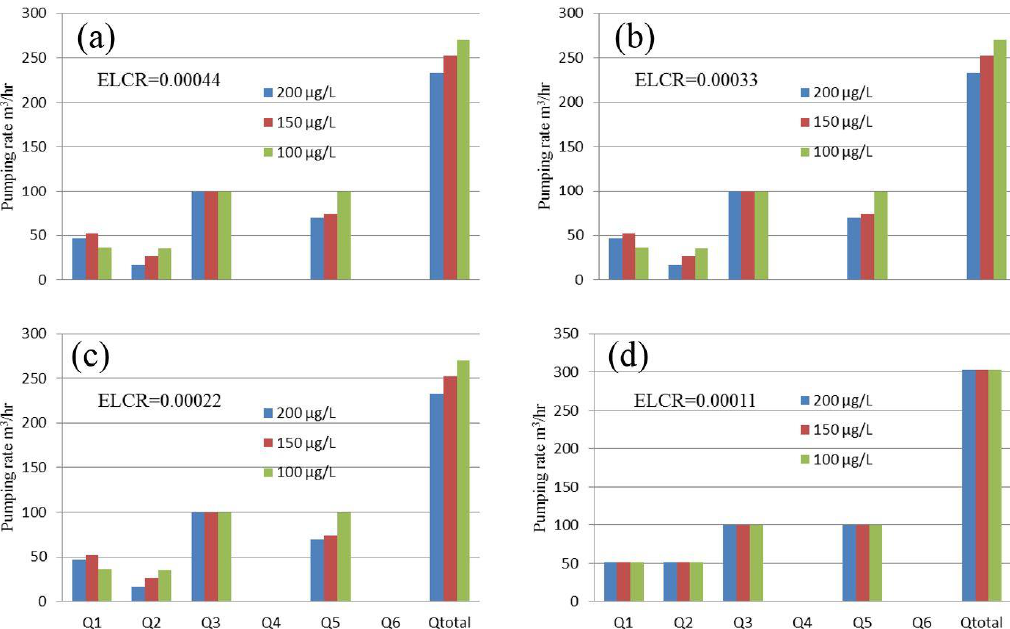
Figure 3. Optimization pumping rates under different scenarios when the remediation duration is 5 years, where (a), (b), (c), (d) are results under the conditions of the allowable ELCR values being 0.00044, 0.00033, 0.00022 and 0.00011, respectively. Water 2018 , 10 , x FOR PEER REVIEW 12 of 16